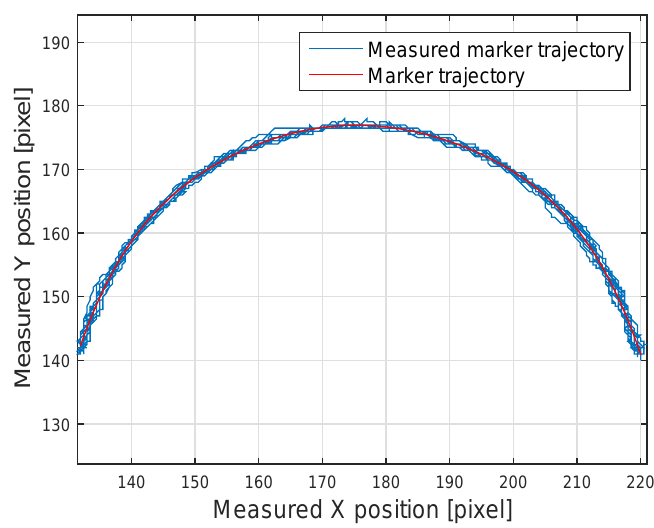
Figure 15. Measured vs. theoretic moving marker track.